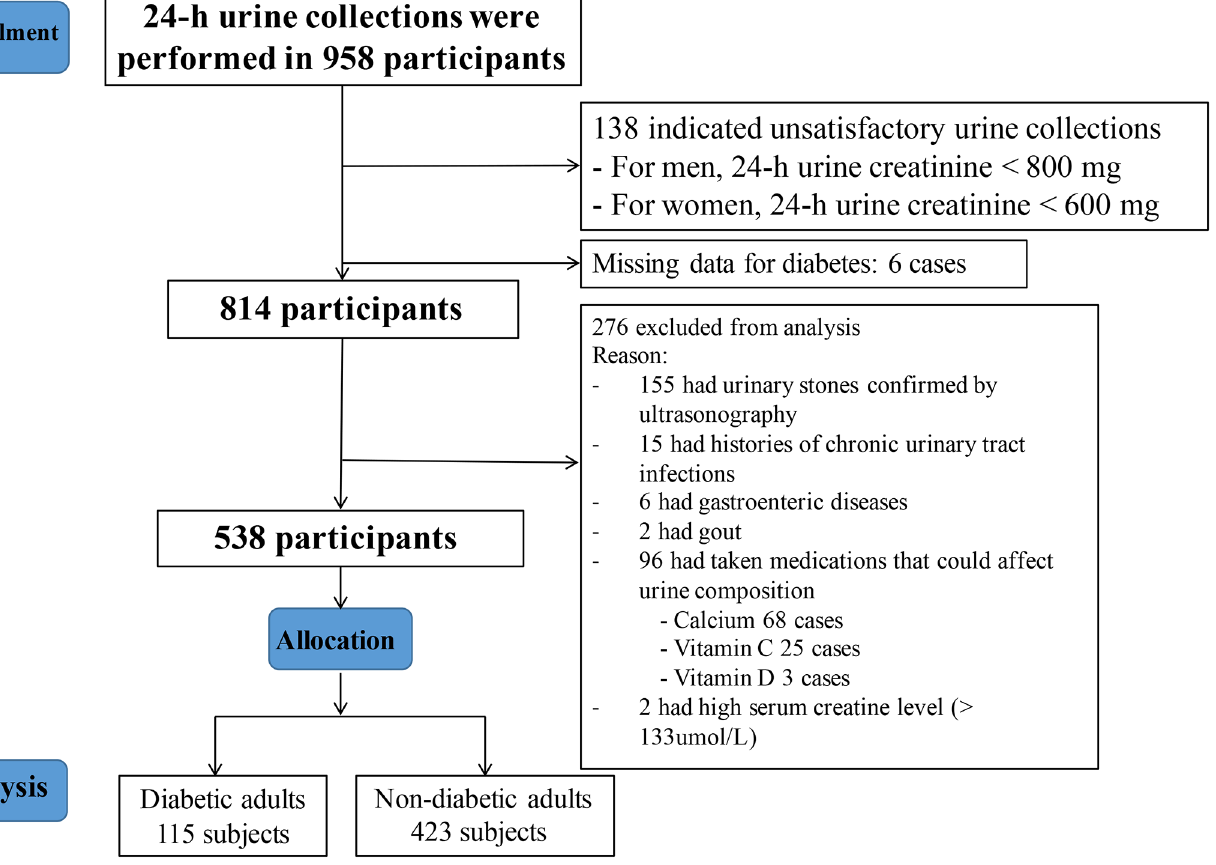
Fig 1. CONSORT flow diagram. Subject selection